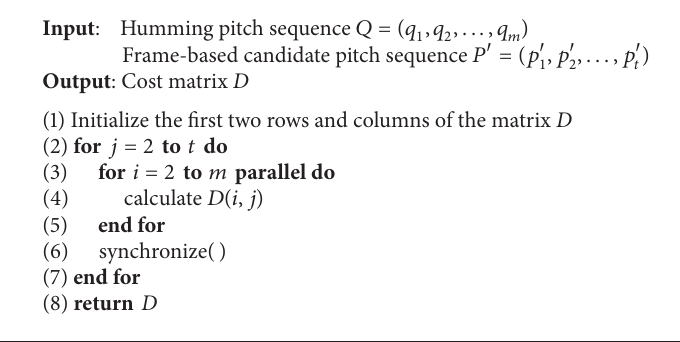
Algorithm 2: Parallel implementation for calculating the matrix D PDTW (𝑄, 𝑃) .